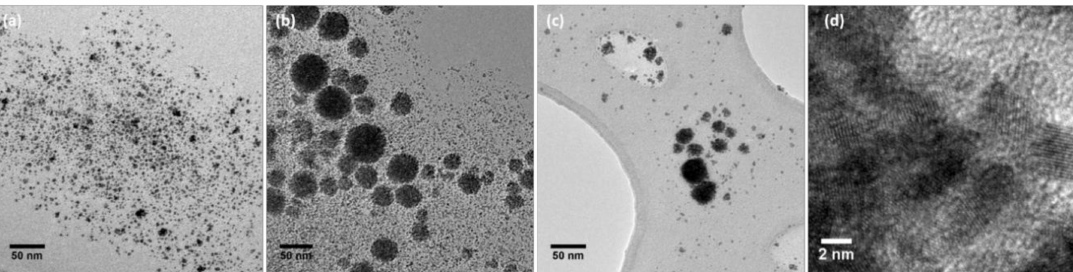
Figure 2. TEM images of M1A ( a ), M1B ( b ) and M2 ( c ). HRTEM image of M2 ( d